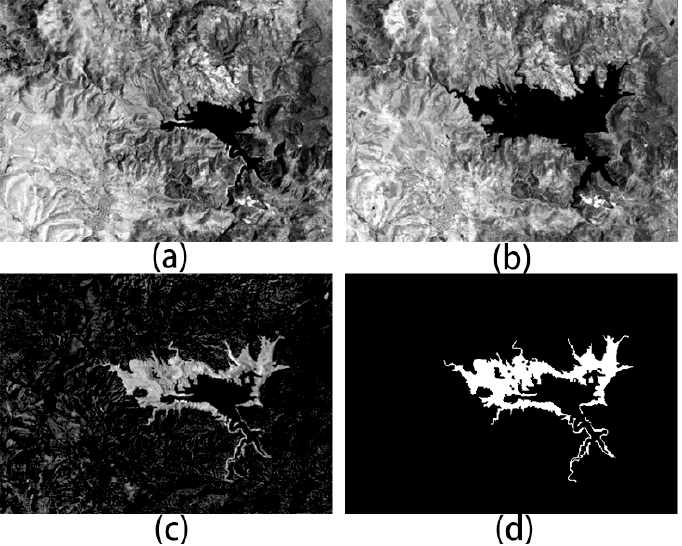
Figure 11. Fourth dataset: Sardinia Island (Italy) dataset, band 4 of the Landsat TM image captured in ( a ) September 1995; and ( b ) July 1996; ( c ) corresponding CMI generated through the difference method; and ( d ) reference of the changed area.